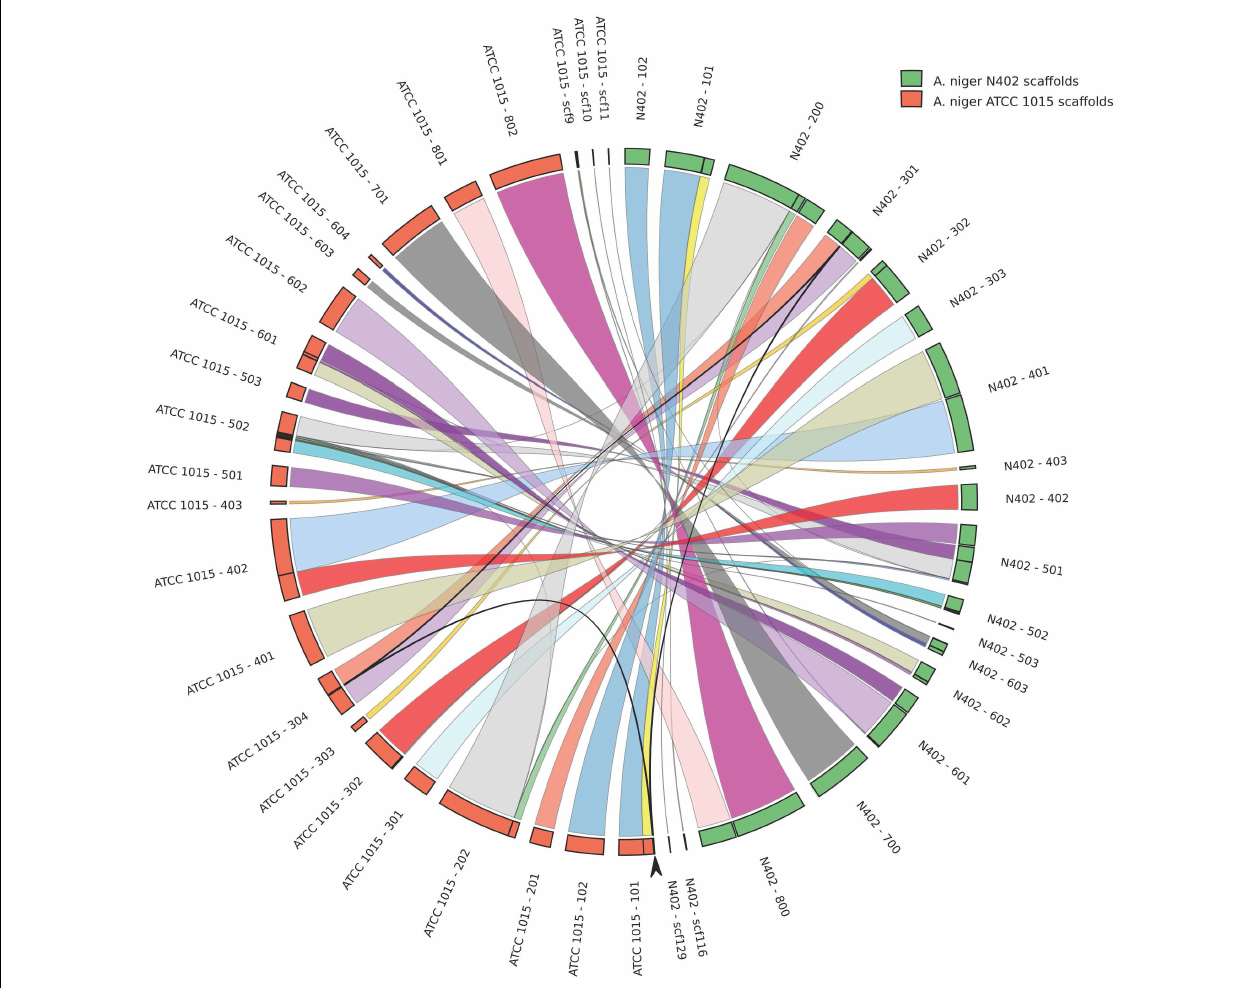
FIGURE 2 | High levels of sequence identity and synteny between the proposed genome assemblies of Aspergillus niger strains N402 and ATCC 1015. Genome comparison is plotted in circos format (Krzywinski et al., 2009). Arrow indicates a 50.3 kb region present in chromosome 3 in the N402 and the ATCC1015 genome assembly coding for 21 predicted genes which is repeated on scaffold 101 in the proposed assembly of strain